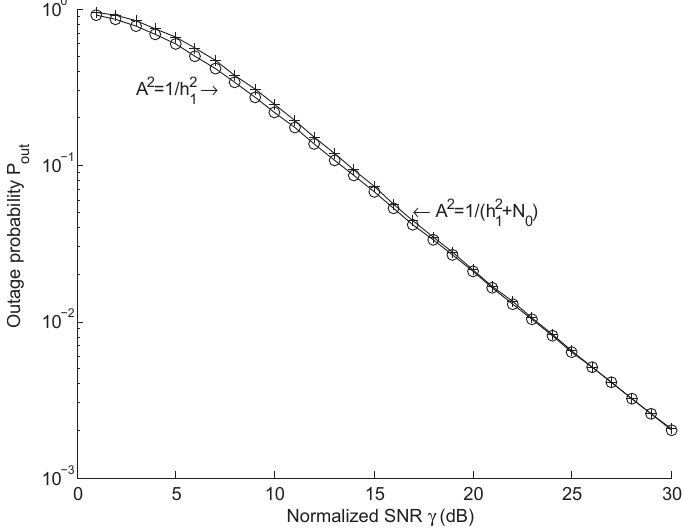
Figure 4. A Monte Carlo simulation for the different types of Amplify-and-Forward (AF) relay gain A